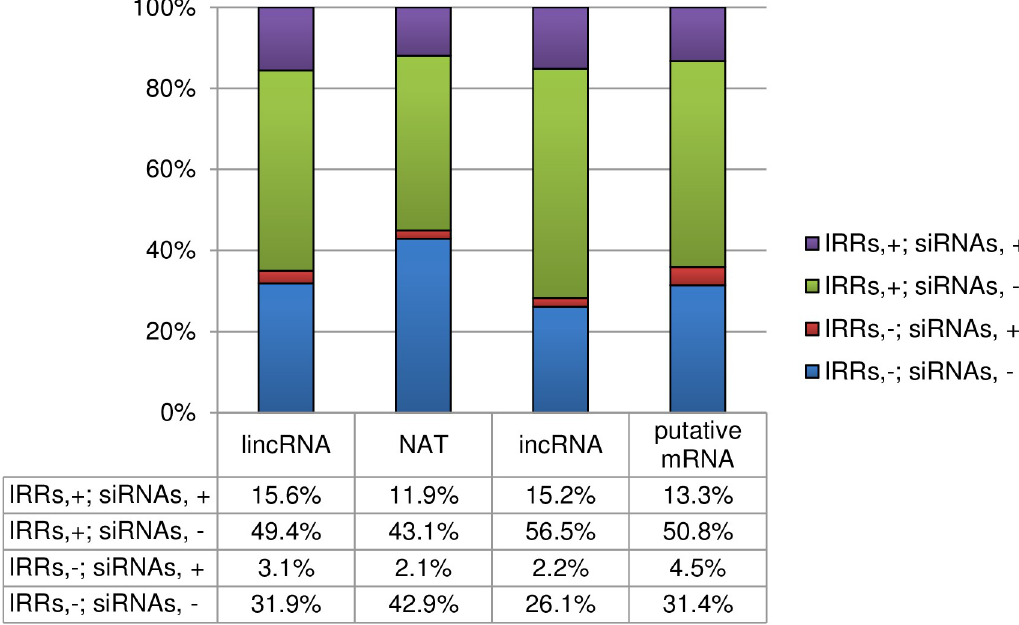
Fig 2. Proportion of each type of lncRNA and putative mRNAs that overlap with IRRs and siRNA. “+” indicates with and “-” indicated without overlapping IRRs or genomic regions encoding siRNAs.